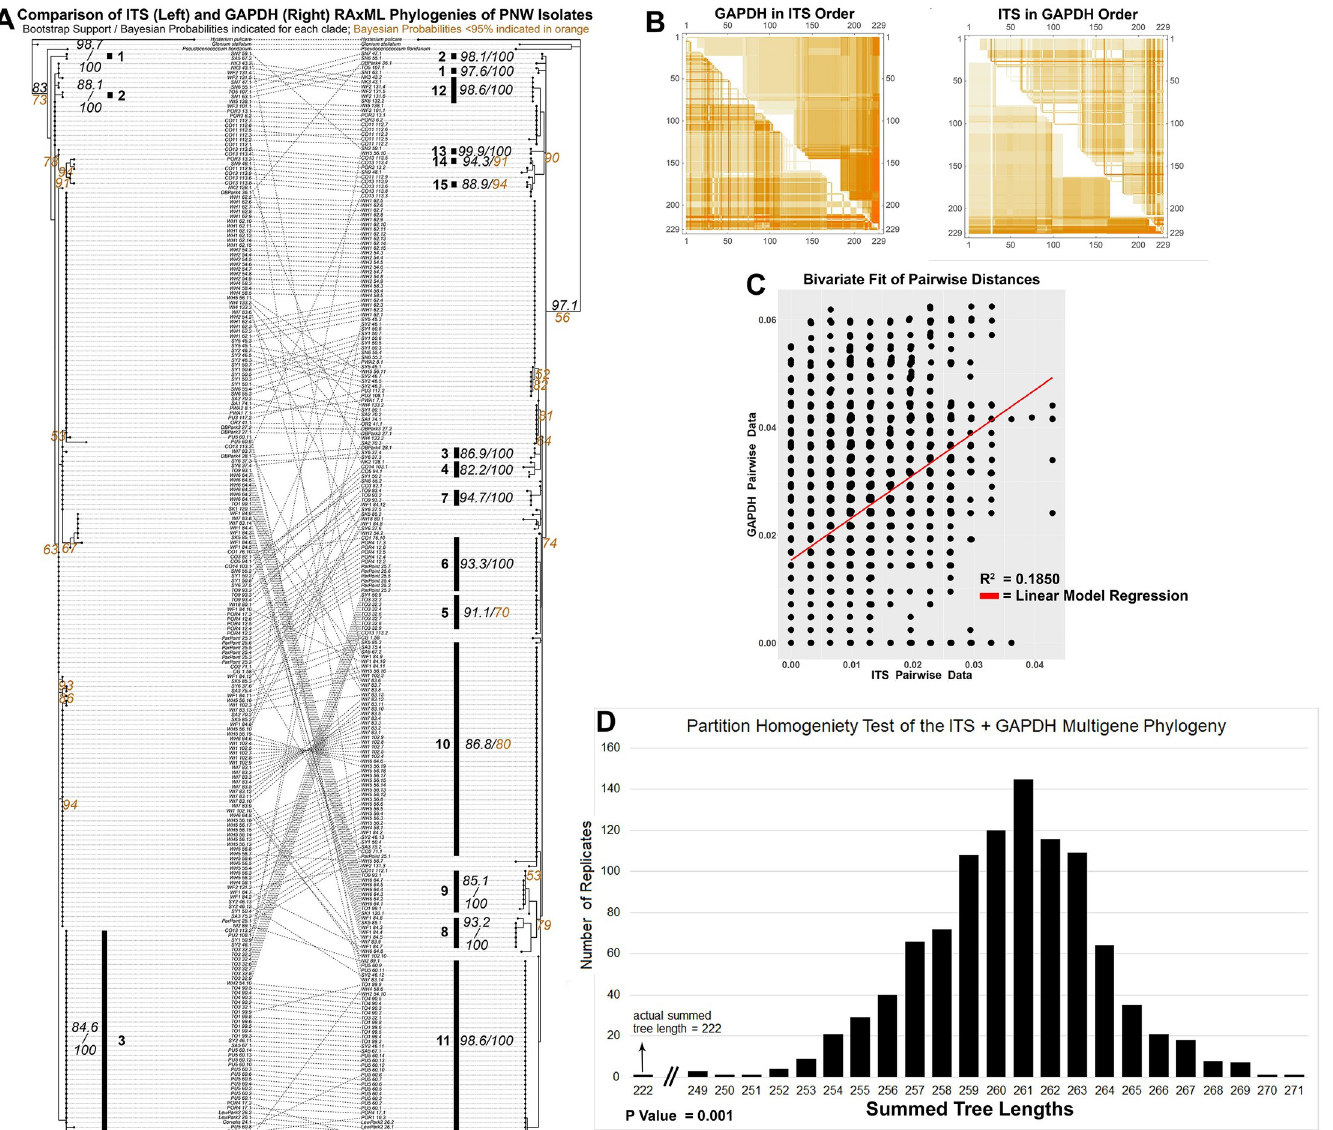
Fig 3. Phylogenetic incongruence between the ITS (left) and GAPDH (right) RAxML phylogenies (A). Heatmap showing pairwise distances for ITS and GAPDH genes from Cenococcum geophilum . Genetic distances (HKY85) were calculated among all sequence pairs for ITS (above diagonal) and GAPDH (below diagonal). Darker color indicates higher sequence divergence. The first is sequence order based on UPGMA clustering of ITS distances, the second is sequence order based on UPGMA clustering of GAPDH distances (B). A scatterplot of pairwise HKY85 distances for ITS vs GAPDH datasets shows low correlation between the ITS and GAPDH gene regions (C). The parsimony-based inter-partition length difference (PTP-ILD)test indicated that the ITS and GAPDH data sets are incongruent due to no significant difference between the observed data set parsimony trees and the distribution of the randomized tree length calculations (p = 0.001) (D).